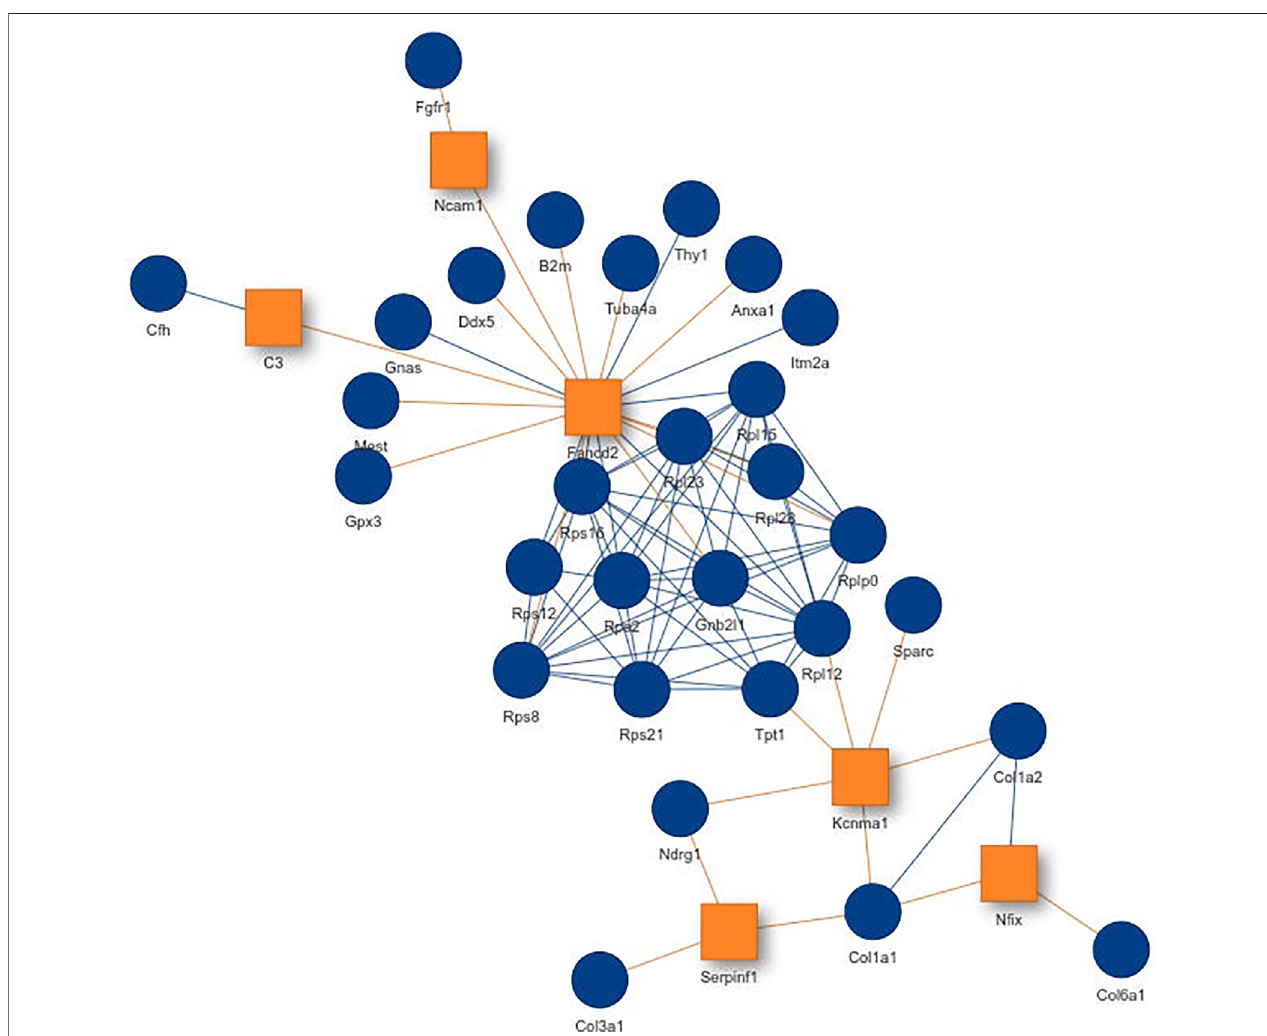
FIGURE7| Networkfromsinglecelldataofsatellitestemcellsfromthemurinelimbmusclewiththecon fi guration K (cid:1) 6and L (cid:1) 4.Exceptionnodesarevisualizedas orange squares and signi fi cant nodes as blue circles.